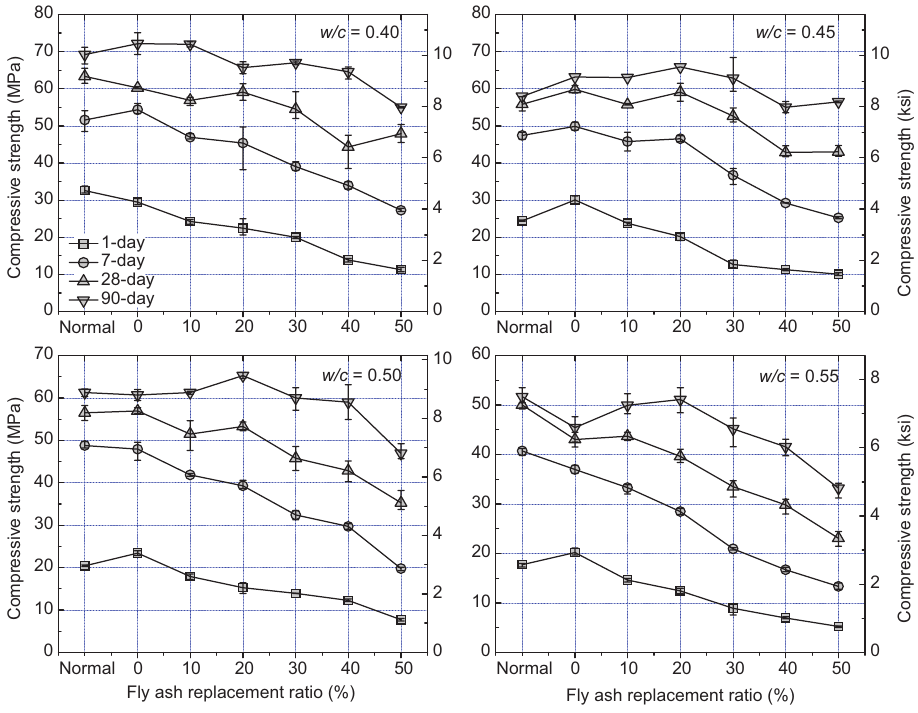
Figure 4 Compressive strength of “ sandless ” concrete with different w/c